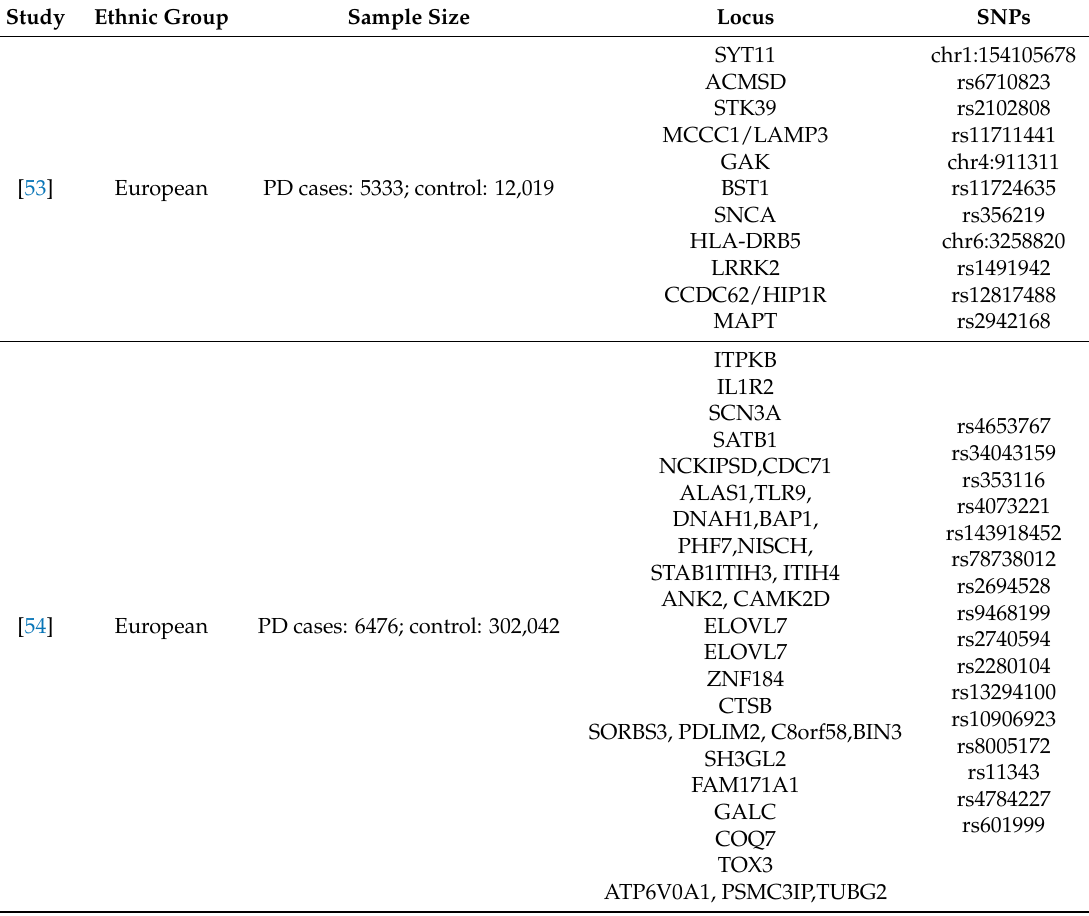
Table 4. Genome-wide association studies (GWAS) in PD